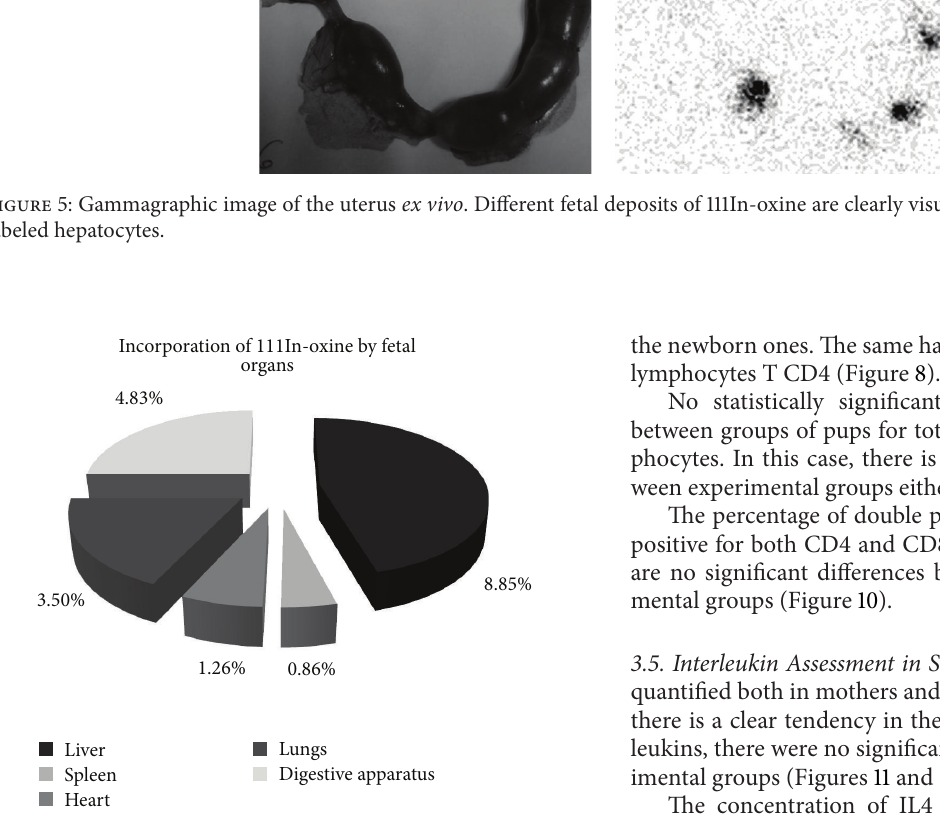
Figure 6: Incorporation of 111In-oxine by different fetal organs. Hepatocytes were mostly located in the liver. There were other deposits found at the digestive apparatus, lungs, heart, or spleen, although the proportion of these was smaller than the amount in the